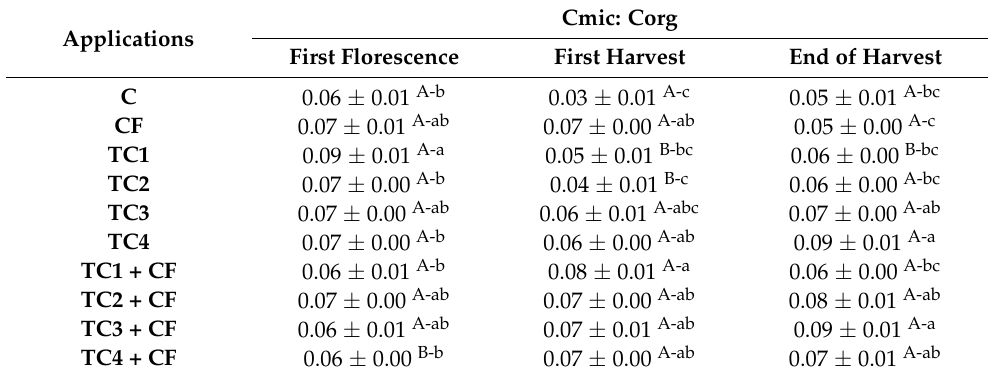
Table 6. Cmic:Corg ratio values.